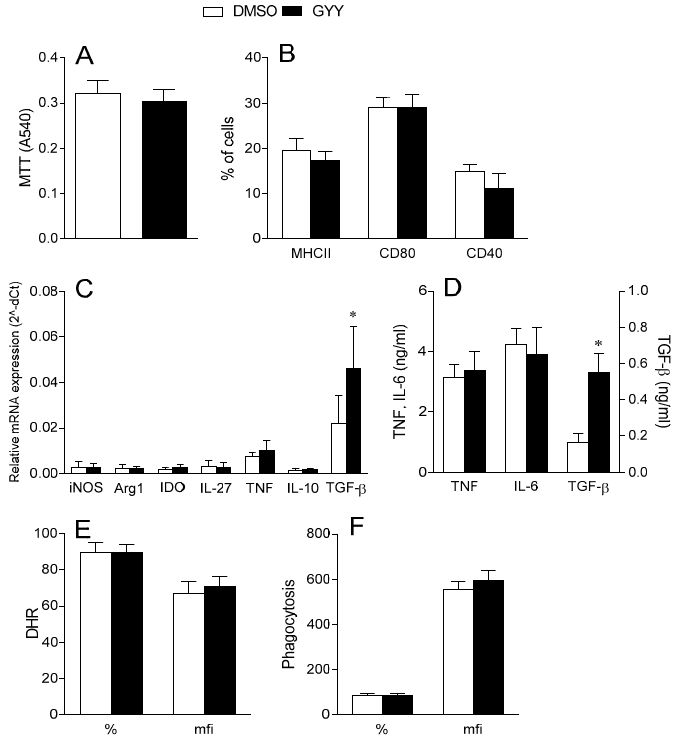
Figure 1. Effects of GYY4137 on bone marrow-derived dendritic cells (BMDCs). BMDCs were propagated from mouse bone marrow precursors in the presence of Granulocyte-macrophage colony-stimulating factor (GM-CSF) and matured under the influence of lipopolysaccharide (LPS). Moreover, 200 μ M GYY4137 (GYY) was applied simultaneously with LPS and DMSO was used as the vehicle control (DMSO). The cell viability was determined by the MTT test ( A ), the expression of MHC II, CD80 and CD40 was determined by cytofluorimetry ( B ), the mRNA expression relative to β -actin was detected by real-time RT-PCR ( C ), the cytokine concentrations were determined by ELISA ( D) , phagocytosis was determined by cytofluorimetry ( E ), and reactive oxygen species (ROS) production was measured by DHR staining and cytofluorimetry ( F ). Data are presented as the mean + standard deviation (SD) from three ( F ), four ( B ), five ( A , C , E ) or six ( D ) samples. * p < 0.05 refers to